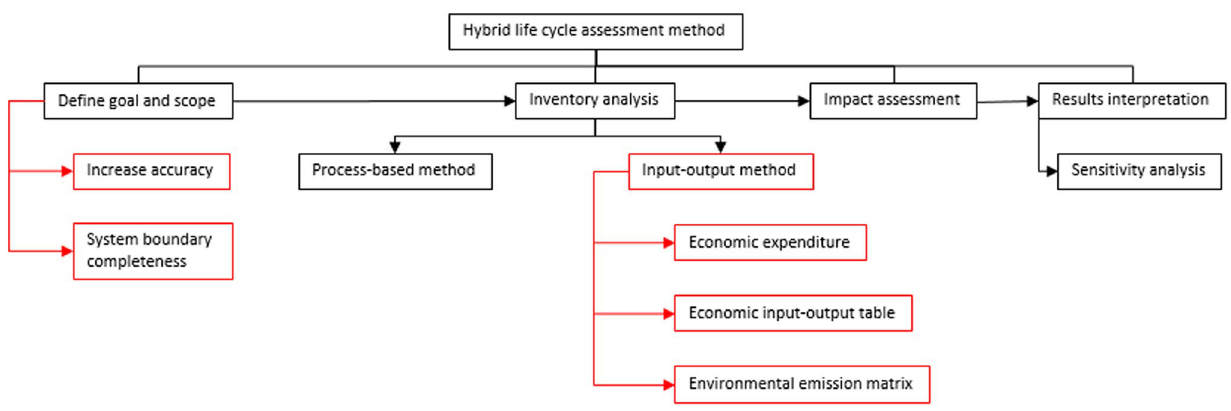
Fig. 1 A schematic illustration of the proposed hybrid LCA method. Boxes in red denote added features and elements related to the IO element of the hybrid